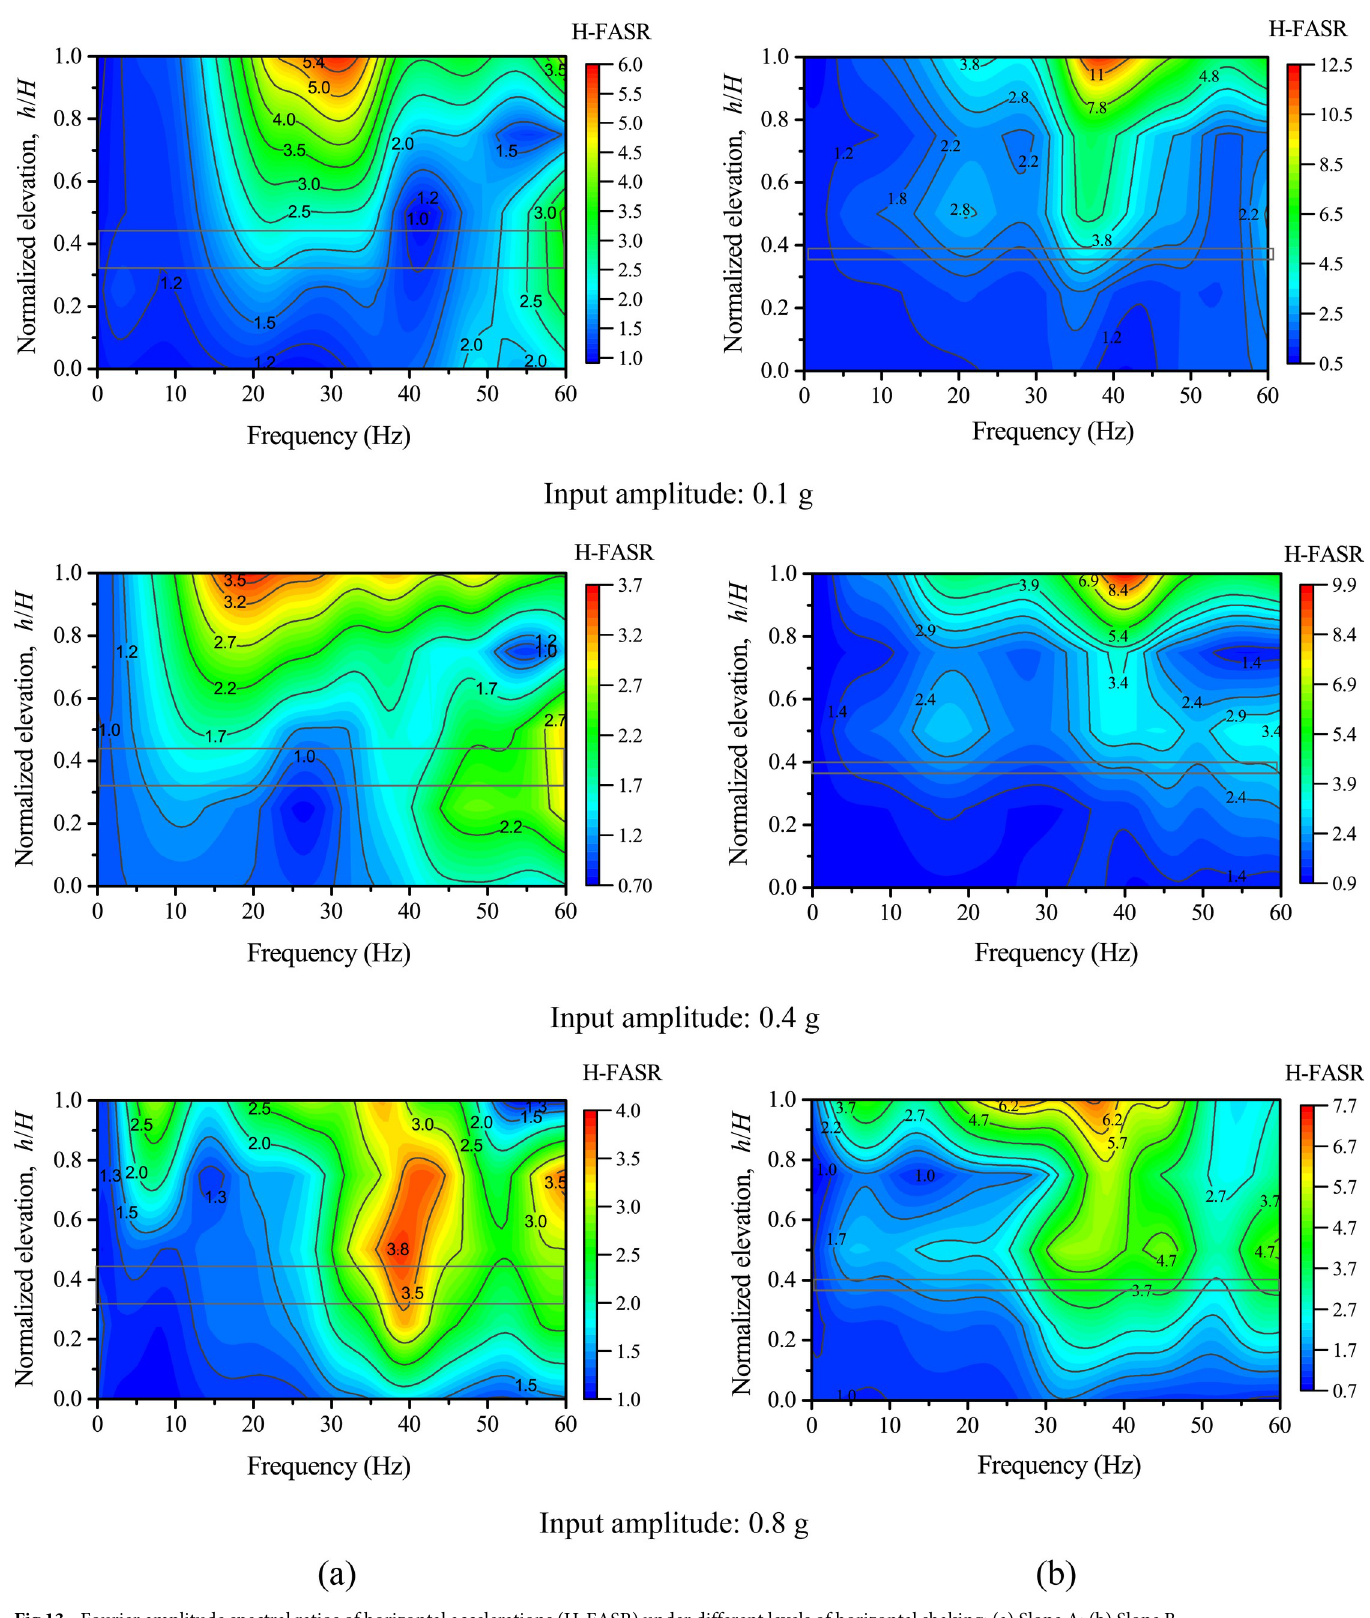
Fig 13. Fourier amplitude spectral ratios of horizontal accelerations (H-FASR) under different levels of horizontal shaking: (a) Slope A; (b) Slope B. https://doi.org/10.1371/journal.pone.0250418.g013 PLOS ONE | https://doi.org/10.1371/journal.pone.0250418 April 21,